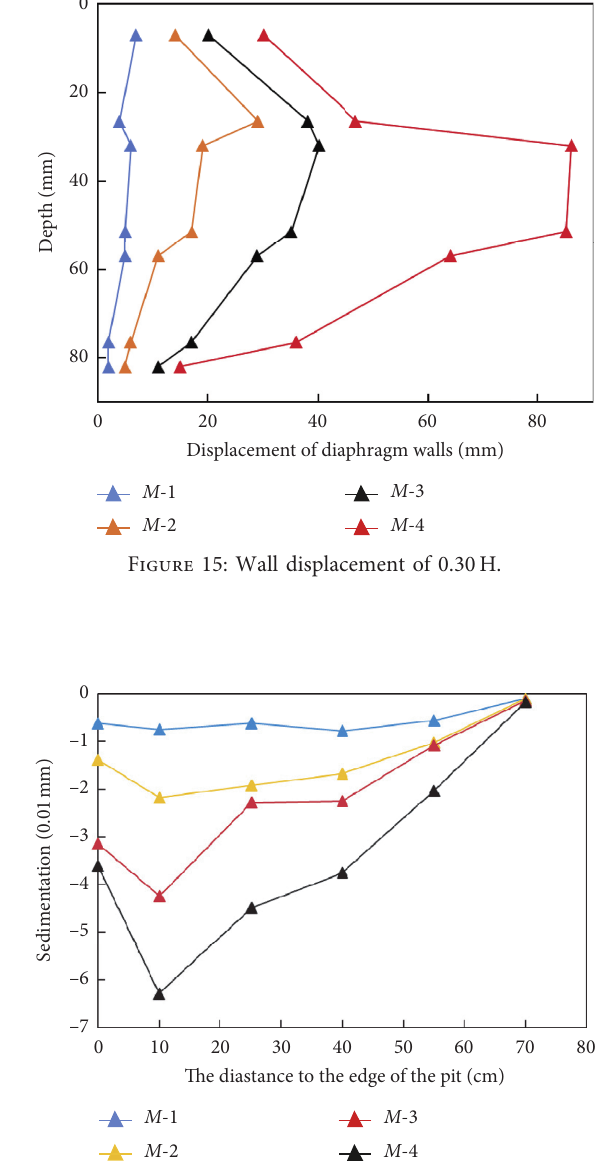
Figure 16: Soil settlement of 0.36